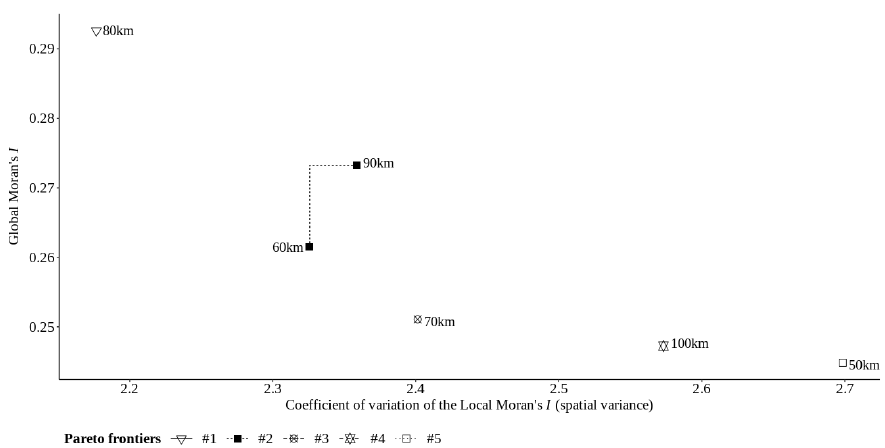
Figure 8. Pareto frontier and trade-off between Global Moran’s I and the coefficient of variation of Local Moran’s I for the O 3 pollutant in California